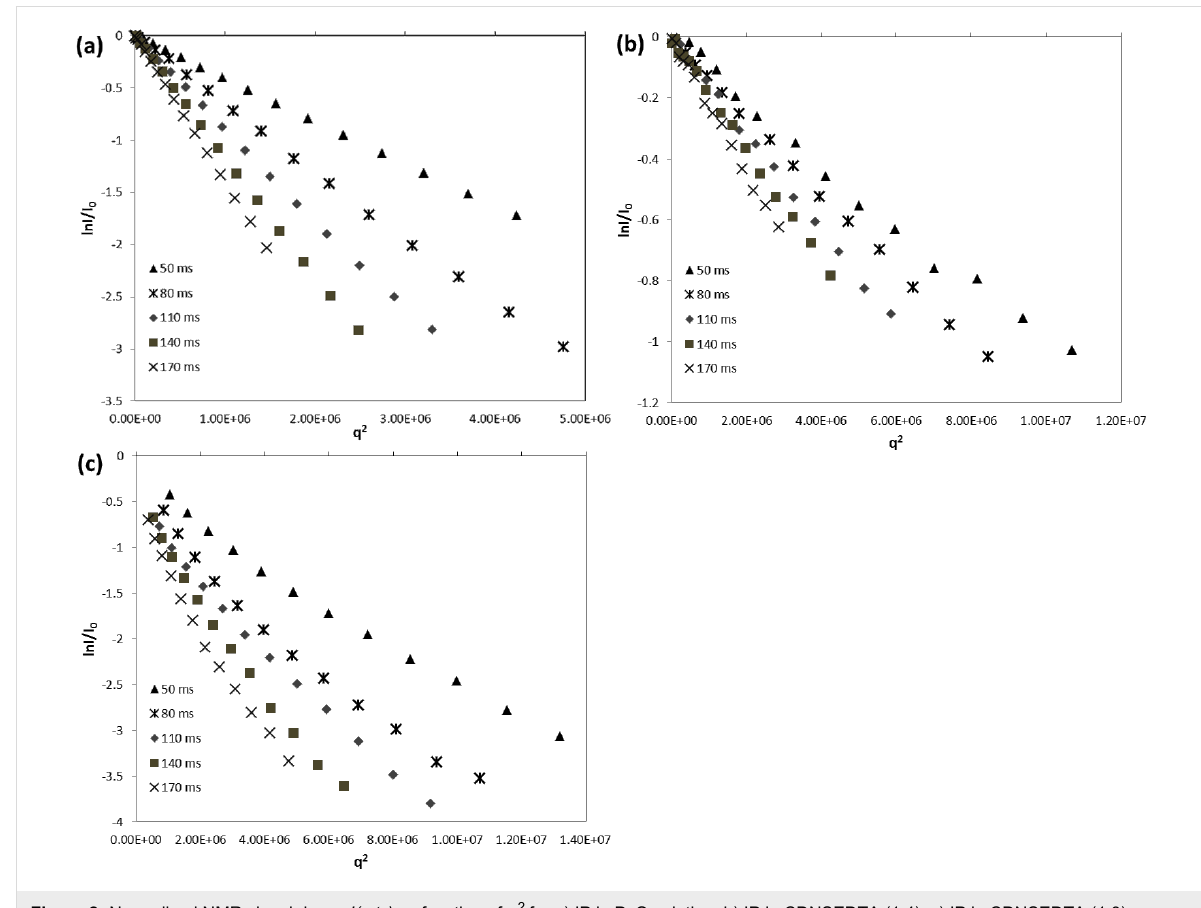
Figure 2: Normalized NMR signal decay I(q,t d ) as function of q 2 for a) IP in D 2 O solution, b) IP in CDNSEDTA (1:4), c) IP in CDNSEDTA (1:8).